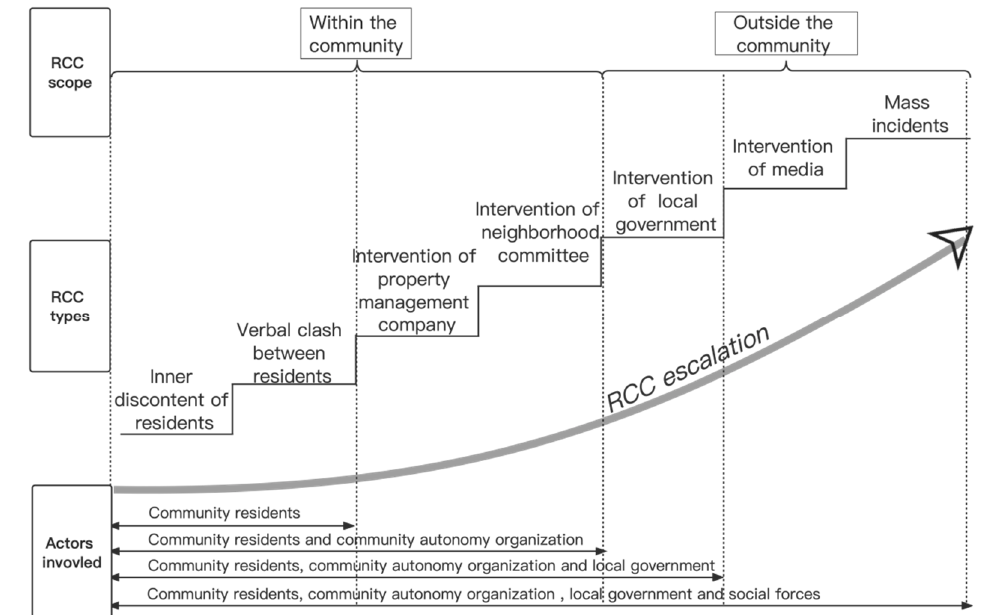
Figure 5. The distribution characteristics of RCC based on RCC escalation. Source: Authors.